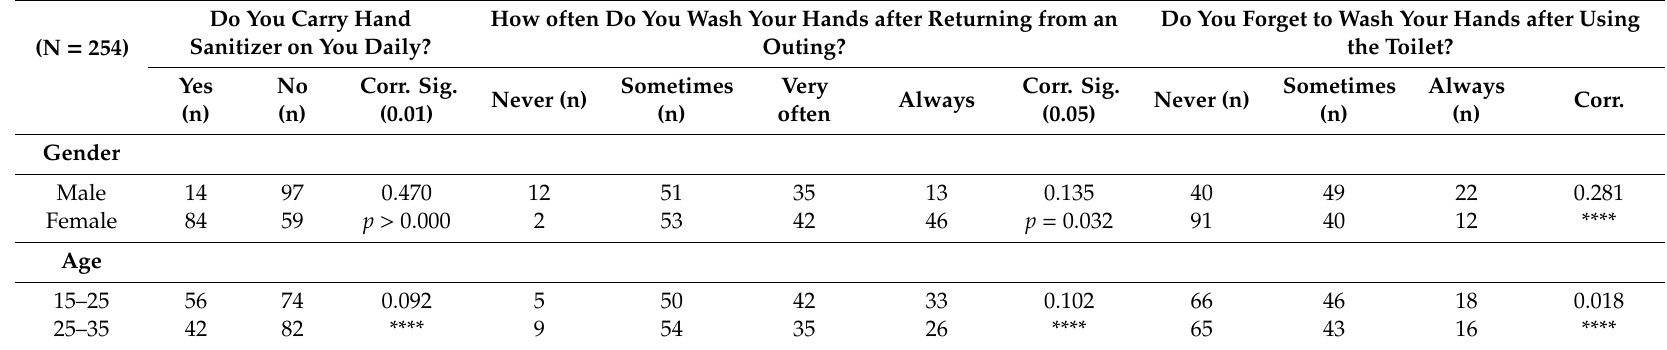
Table 1. Correlation between gender, age and hand hygiene